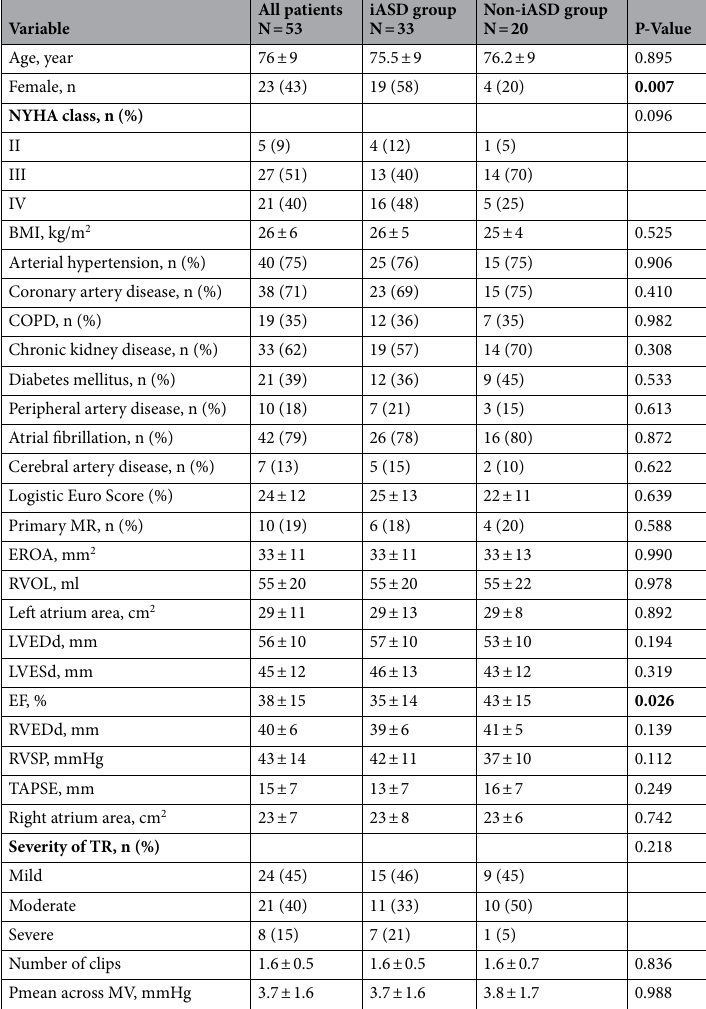
Table 1. Baseline characteristics of study population differentiating iASD and non-iASD group. NYHA New York Heart failure Association, BMI Body Mass Index, COPD Chronic Obstructive Pulmonary Disease, MR mitral regurgitation, EROA Effective regurgitation orifice area, RVOL Regurgitant volume, LVEDd Left Ventricle END Diastolic diameter, LVESd Left Ventricle End Systolic diameter, EF Ejection Fraction, RVEDd Right Ventricle End Diastolic diameter, RVSP Right Ventricle Pressure measured in echocardiography, TAPSE Tricuspid annular plane systolic excursion, TR Tricuspid Regurgitation. Pmean: mean pressure across the mitral